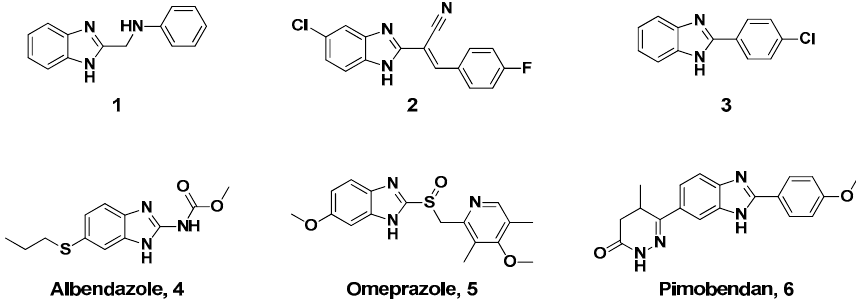
Figure 1. Benzimidazole analogs with various biological activities.